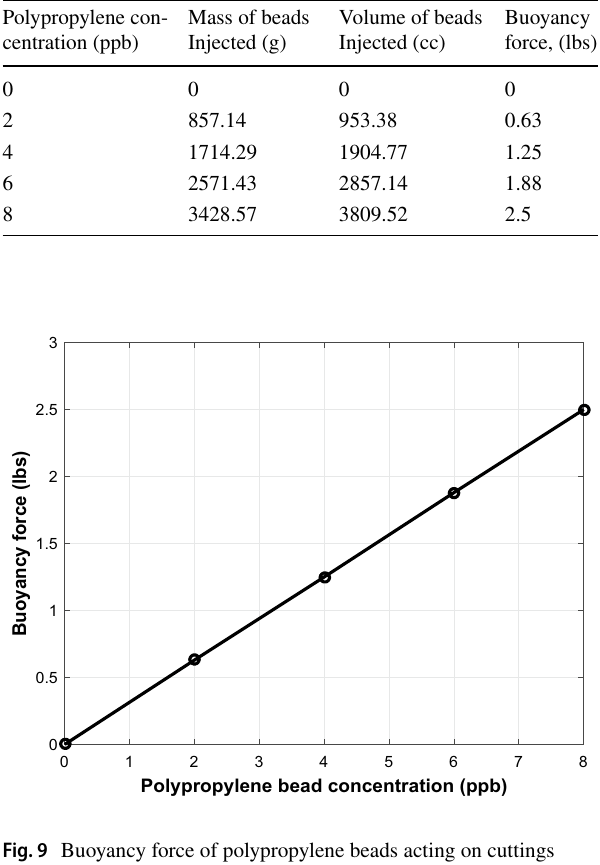
Fig. 9 Buoyancy force of polypropylene beads acting on cuttings